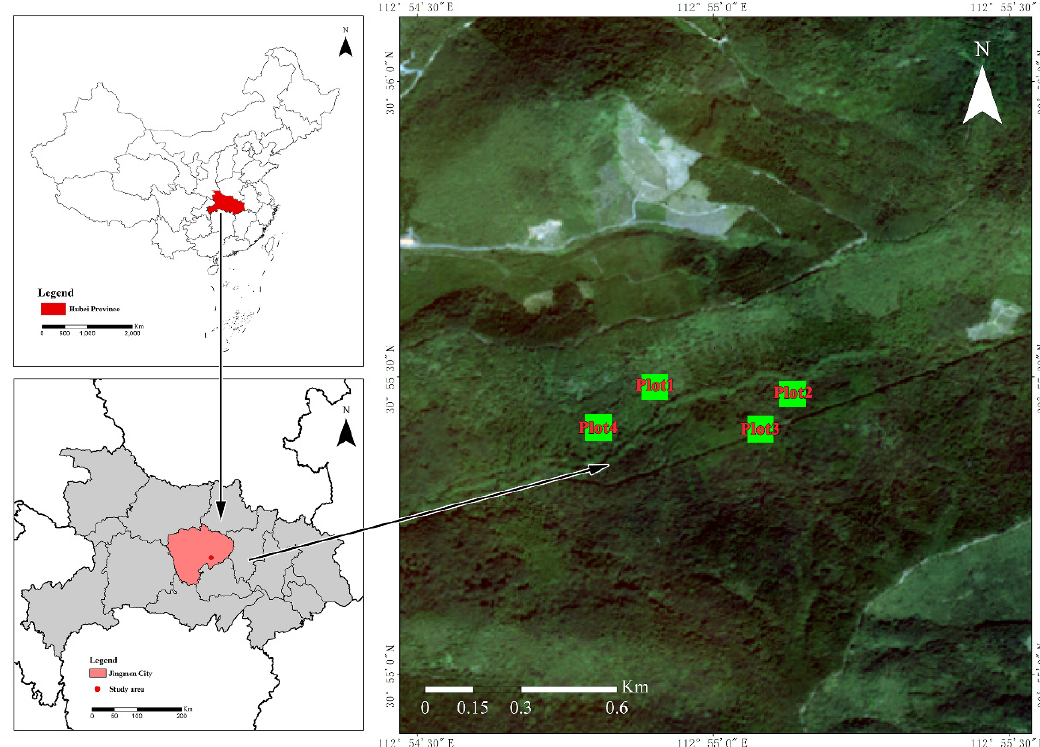
Figure 1. Geographical location of the study area.